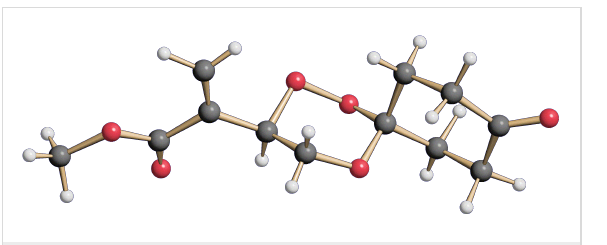
Figure 2: Structure of the spirobicyclic trioxane 5c in the crystal.